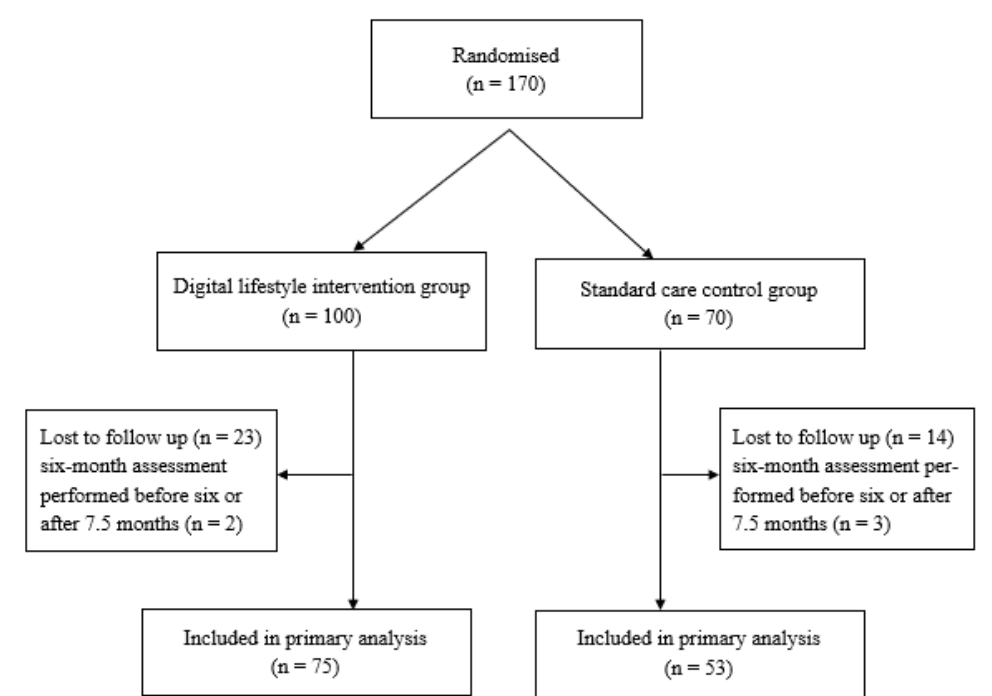
Figure 1. Participant flow